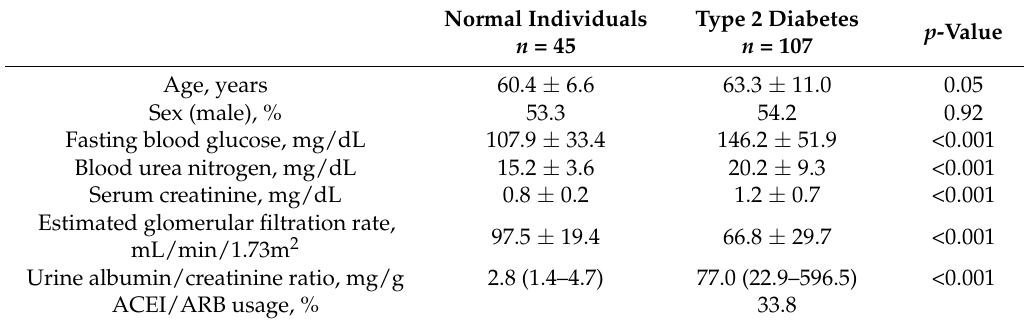
Table 5. The characteristics and metabolic parameters of human participants.